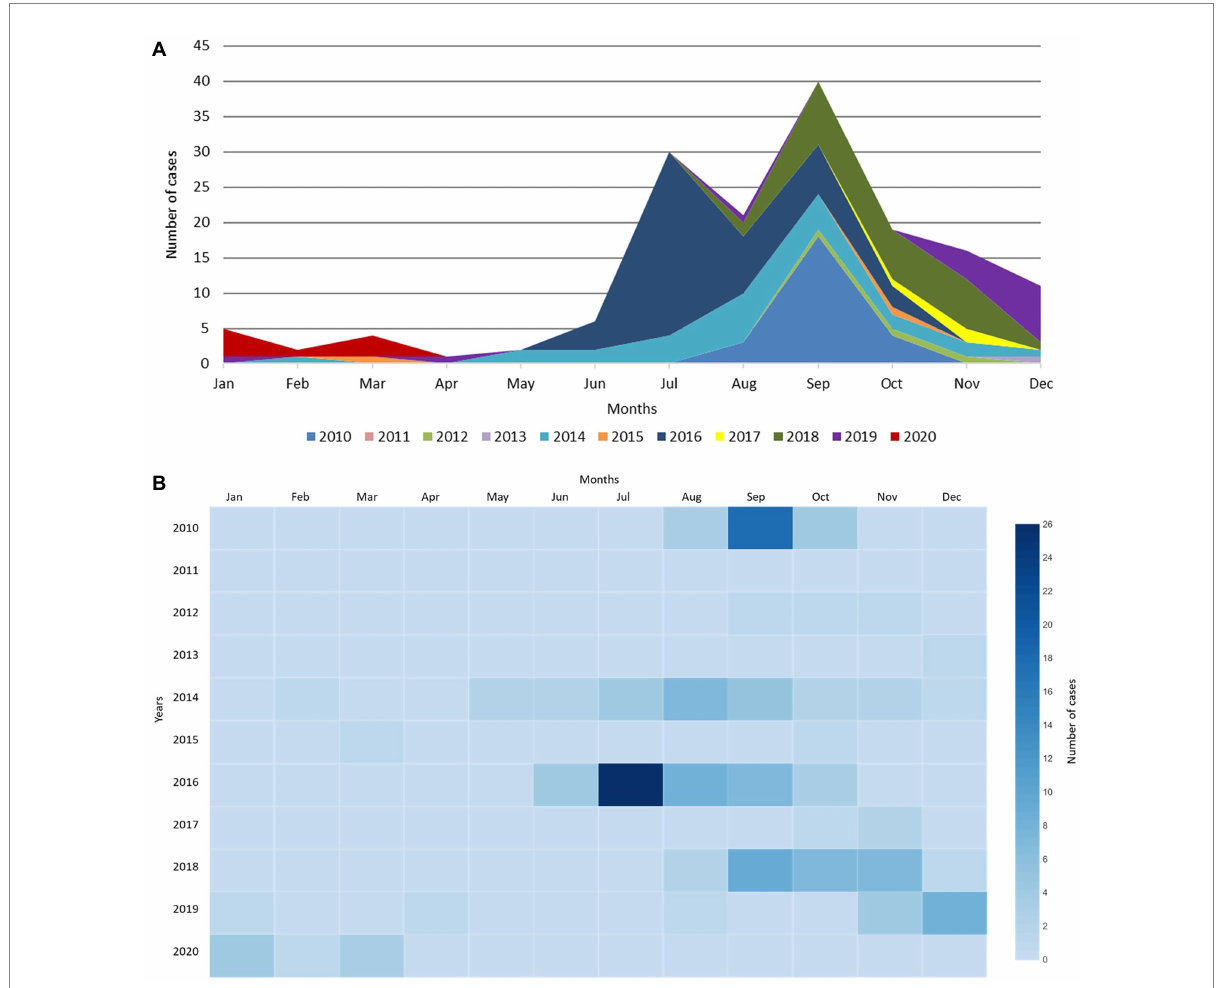
FIGURE 1 EV-D68 detection from January 2010 to March 2020 at the UMCG. (A) EV-D68 detection per month at the UMCG between 2010 and 2020. A distinct rise can be observed which does not follow the usual trend, shown in purple (2019) and red (2020). (B) Heatmap of EV-D68 detection per month at the UMCG between 2010 and